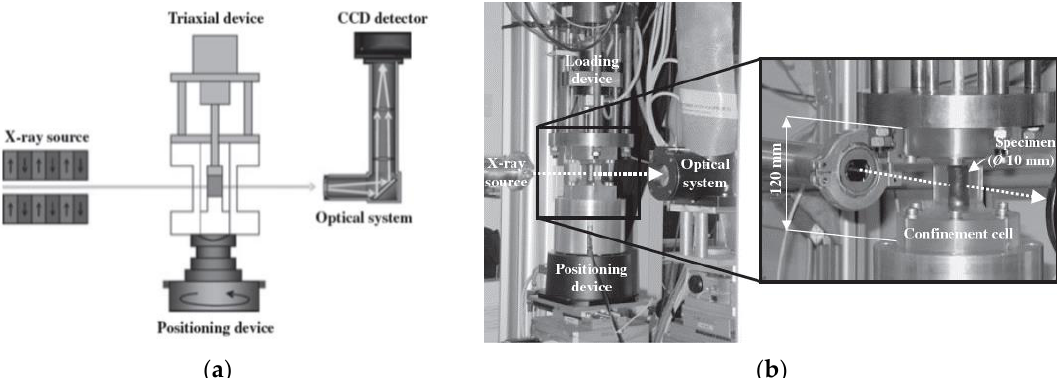
Figure 15. Schematic diagram of the research system in ESRF-EBS synchrotron: ( a ) scheme of the micro-CT device for triaxiel testing; ( b ) experimental setup showing a specimen inside the transparent triaxial cell; (based on [94], with 2021 permission of John Wiley and Sons, License No 5063850124930).